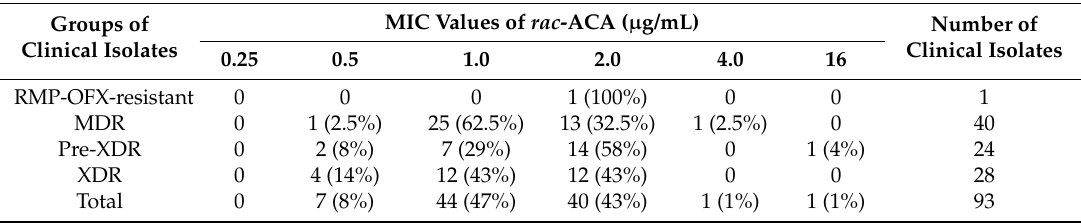
Table 3. MICs of rac -ACA against drug-resistant clinical M. tuberculosis isolates obtained from Siriraj Hospital.